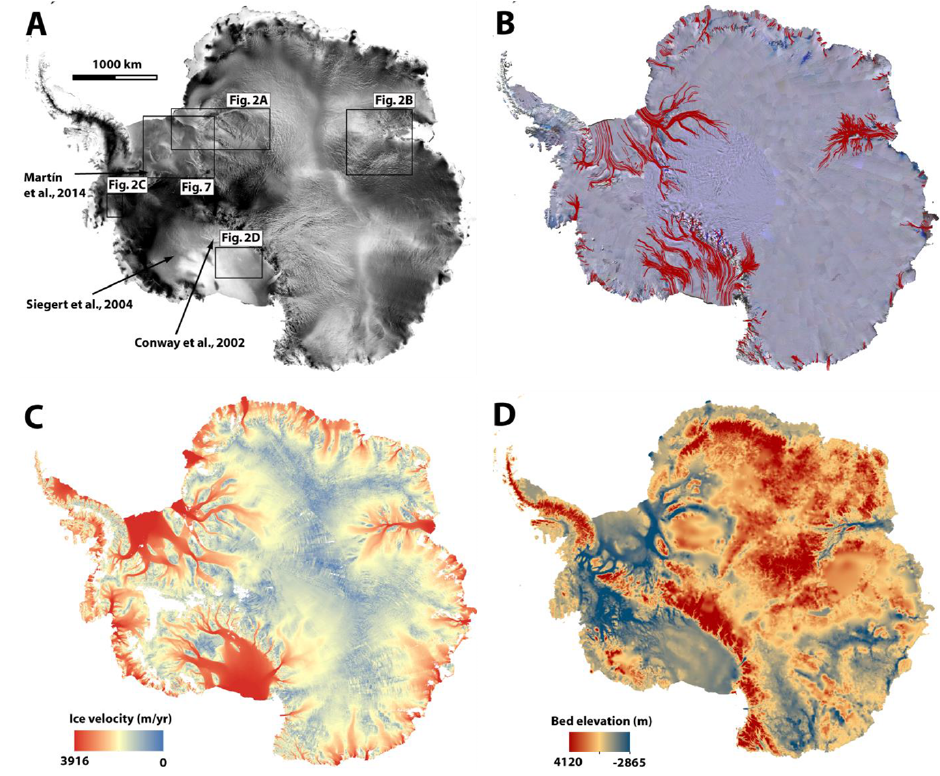
Figure 4. Comparison between longitudinal ice-surface structures and other Antarctic data sets. (a) Synthetic aperture radar (SAR) mosaic of Antarctica showing the surface of the ice sheet (available from https://nsidc.org/data/radarsat/index.html). The locations of enlarged areas shown in Figs. 2a to d and Fig. 5 are indicated. Locations of radar stratigraphic studies of Conway et al. (2002), Siegert et al. (2004) and Martín et al. (2014) are also shown. (b) Continent-wide distribution of longitudinal ice-surface structures on the Antarctic Ice Sheet draped over the LIMA mosaic. (c) Velocity map of the Antarctic continent from the MEASURES project (Rignot et al., 2011). (d) Subglacial topography of Antarctica as compiled in BEDMAP-2 (Fretwell et al., 2013). Note that the location of longitudinal ice-surface structures mirrors areas of rapid velocity in areas underlain by deep subglacial